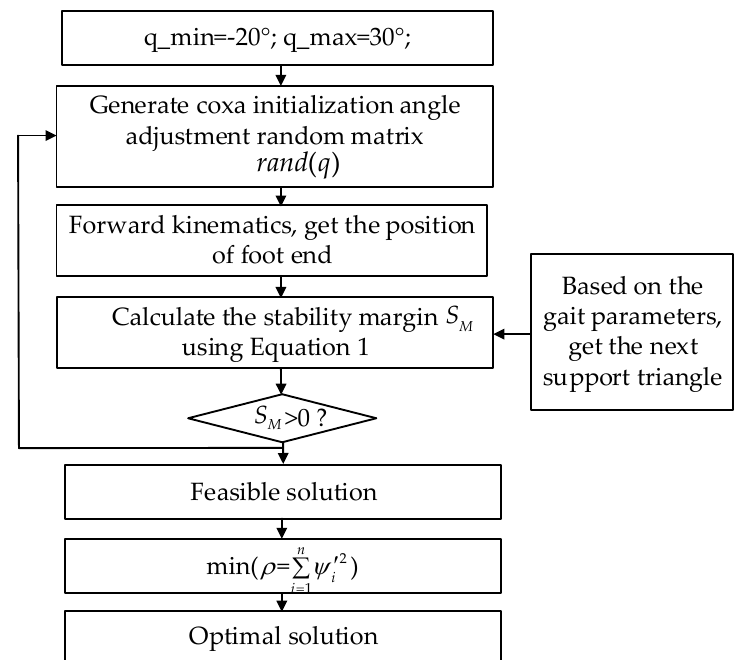
Figure 11. The method to obtain the adjusted angle.